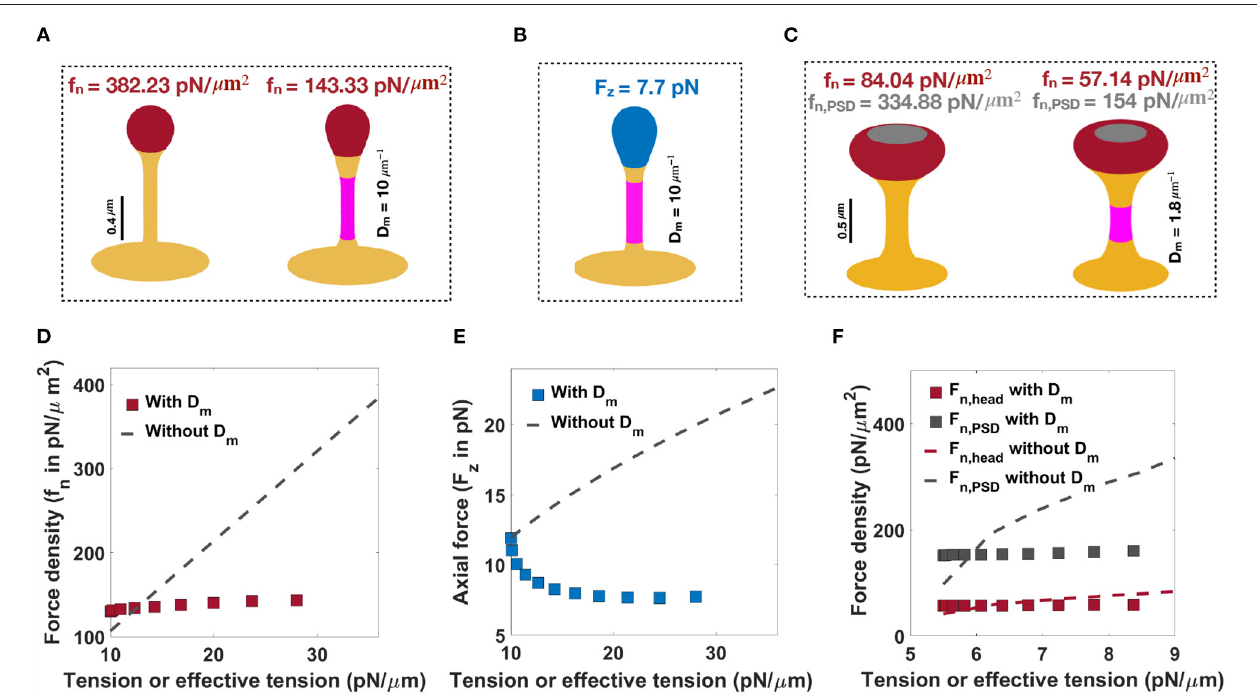
FIGURE 6 | Formation of thin and mushroom shaped spines with a combination of forces and spontaneous deviatoric curvature. (A) Formation of a thin-shaped spine by applying a uniform normal force density along the spine head (left) vs. applying a uniform normal force density along the head and spontaneous deviatoric curvature (purple region) along the spine neck (right) ( λ = 10 pN /µ m). (B) Formation of a thin-shaped spine by applying an axial force along the spherical cap (blue region) and spontaneous deviatoric curvature along the spine neck (purple region), λ = 10 pN /µ m. All thin spines in (A,B) have a neck radius r 0.05 µ m and head volume V ∼ ∼ 0.033 µ m 3 . (C) Formation of a mushroom-shaped spine by applying a non-uniform normal force density along the spine head (left) vs. applying a non-uniform normal force density along the head and spontaneous deviatoric curvature along the spine neck (purple region), (right), λ = 5.5 pN /µ m. The formed mushroom spine with normal force densities f n 57.14 pN /µ m 2 and f n,PSD 154 pN /µ m 2 and deviatoric curvature D m 1.8 µ m − 1 has a neck radius r 0.1 µ m and head volume V = = = ∼ ∼ 0.27 µ m 3 . (D) The magnitude of a normal force density that is required to form a thin-shaped spine with and without spontaneous deviatoric curvature as a function of effective tension and tension, respectively. (E) The magnitude of an axial force that is required to form a thin-shaped spine with and without spontaneous deviatoric curvature as a function of effective tension and tension, respectively. (F) The magnitude of normal force densities in the spine head and in PSD that is required to form a mushroom spine with and without spontaneous deviatoric curvature as a function of effective tension and tension,